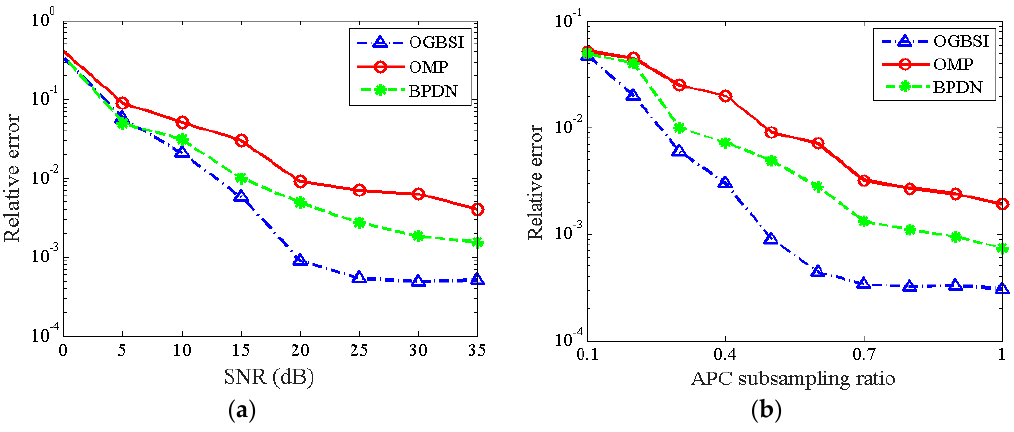
Figure 6. Reconstruction performance for off-grid scatterers: ( a ) relative error of cross-track reconstruction vs. SNR; ( b ) relative error of cross-track reconstruction vs. APC subsampling ratio.